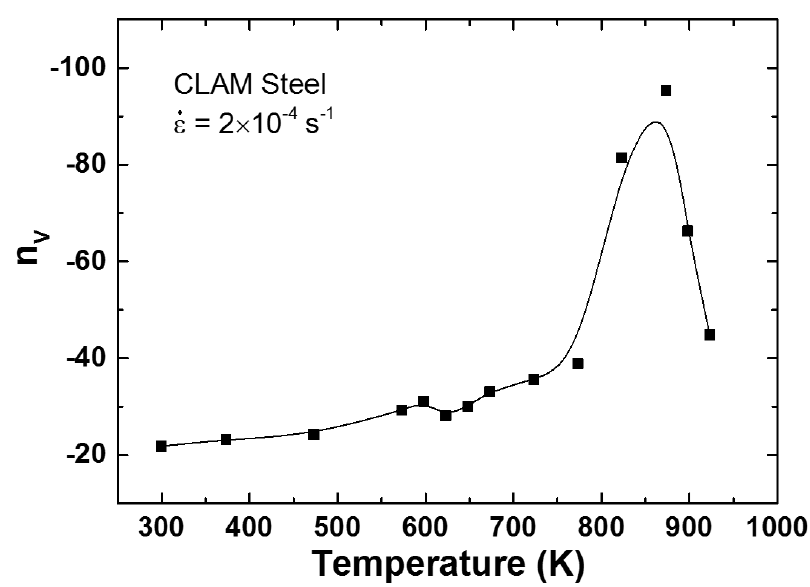
Figure 7. Variation of n V with temperature at strain rate of 2 × 10 − 4 s − 1 in China low activation martensitic (CLAM) steel.